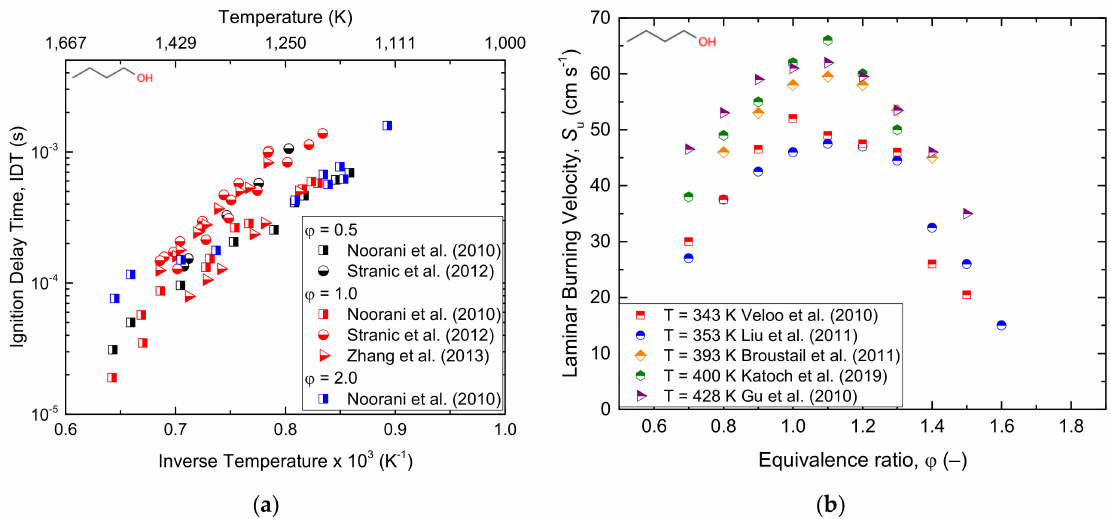
Figure 7. Ignition delay time ( a ) and laminar burning velocity ( b ) of the n -butanol/air mixture under different conditions.